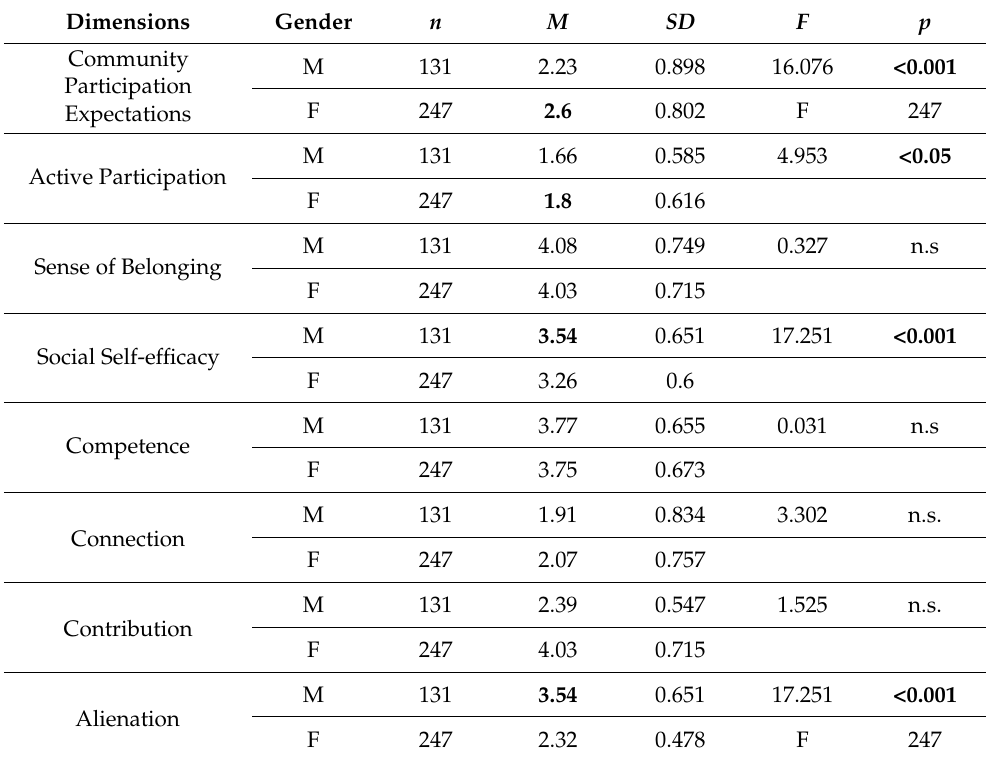
Table 1. Anova comparisons according to gender adapted [32].